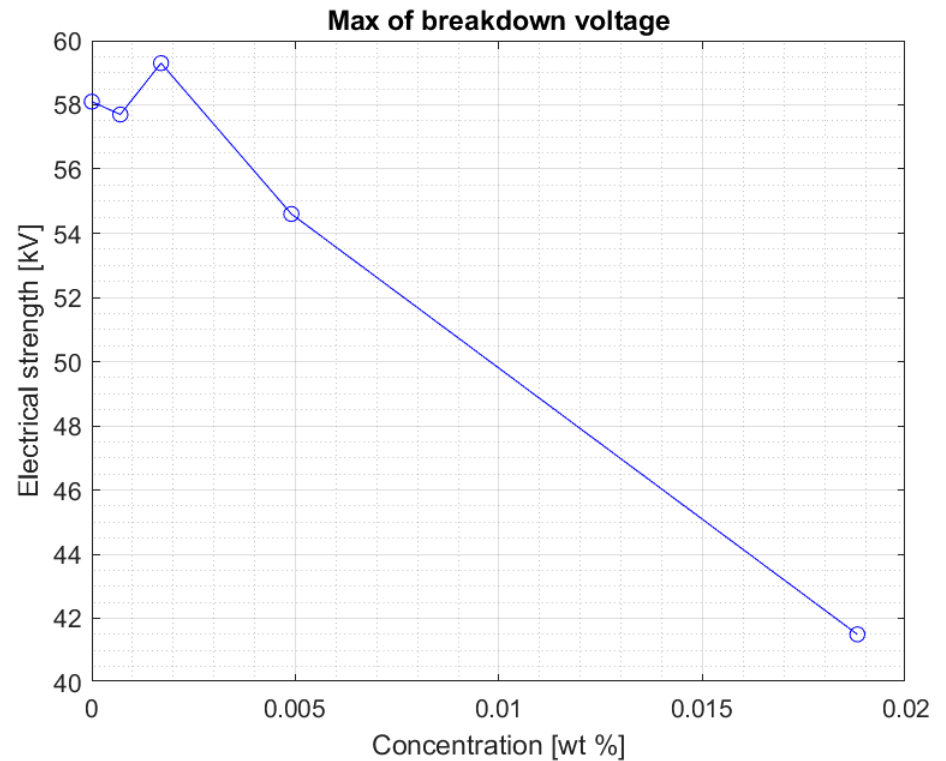
Figure 5. Maximum breakdown voltage values achieved for different nanoparticle concentration in the doped ester five weeks after mixing.